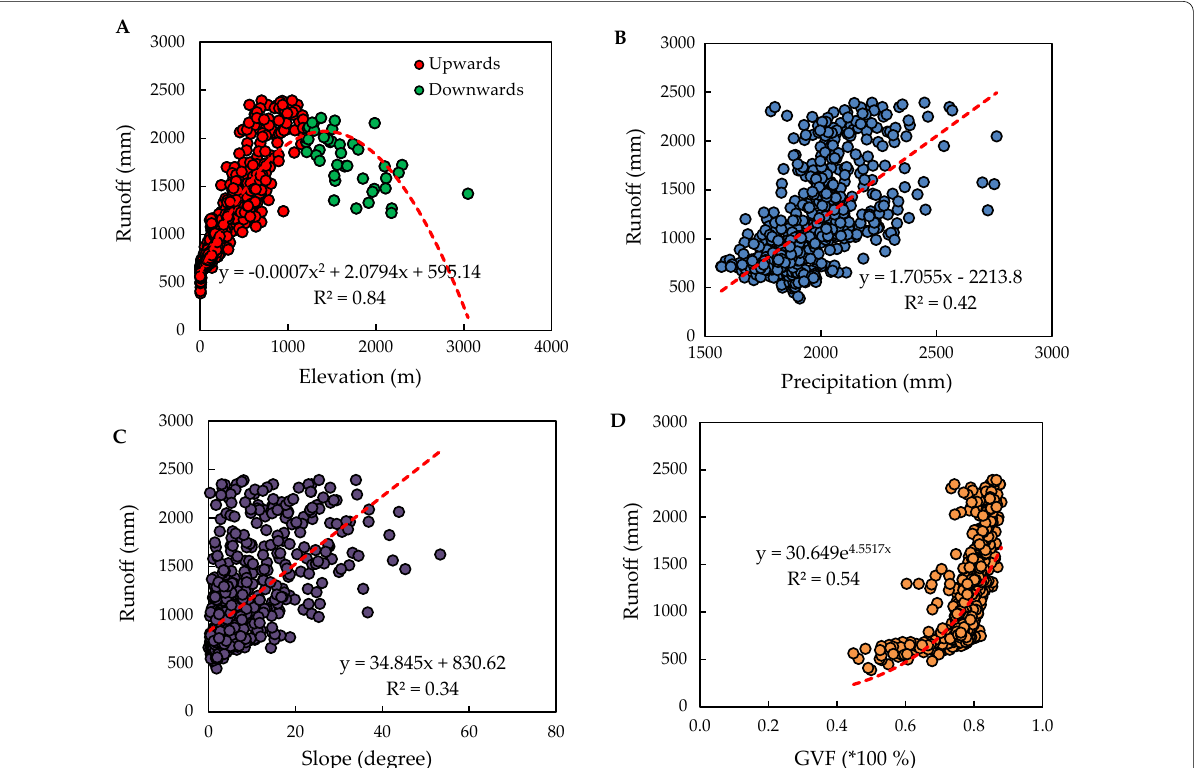
Fig. 8 Scatter plots of runoff and topographic-vegetative factors in Brantas watershed: runoff-elevation ( A ), runoff-precipitation ( B ), runoff-slope ( C ), and runoff-GVF ( D